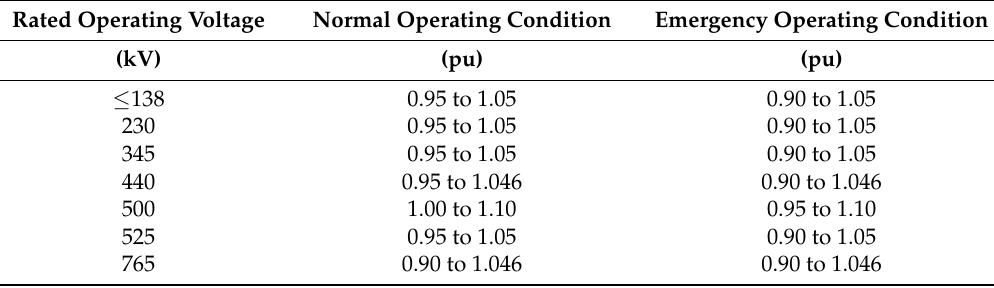
Table 5. Voltage magnitude admissible limits in the Brazilian electrical system.